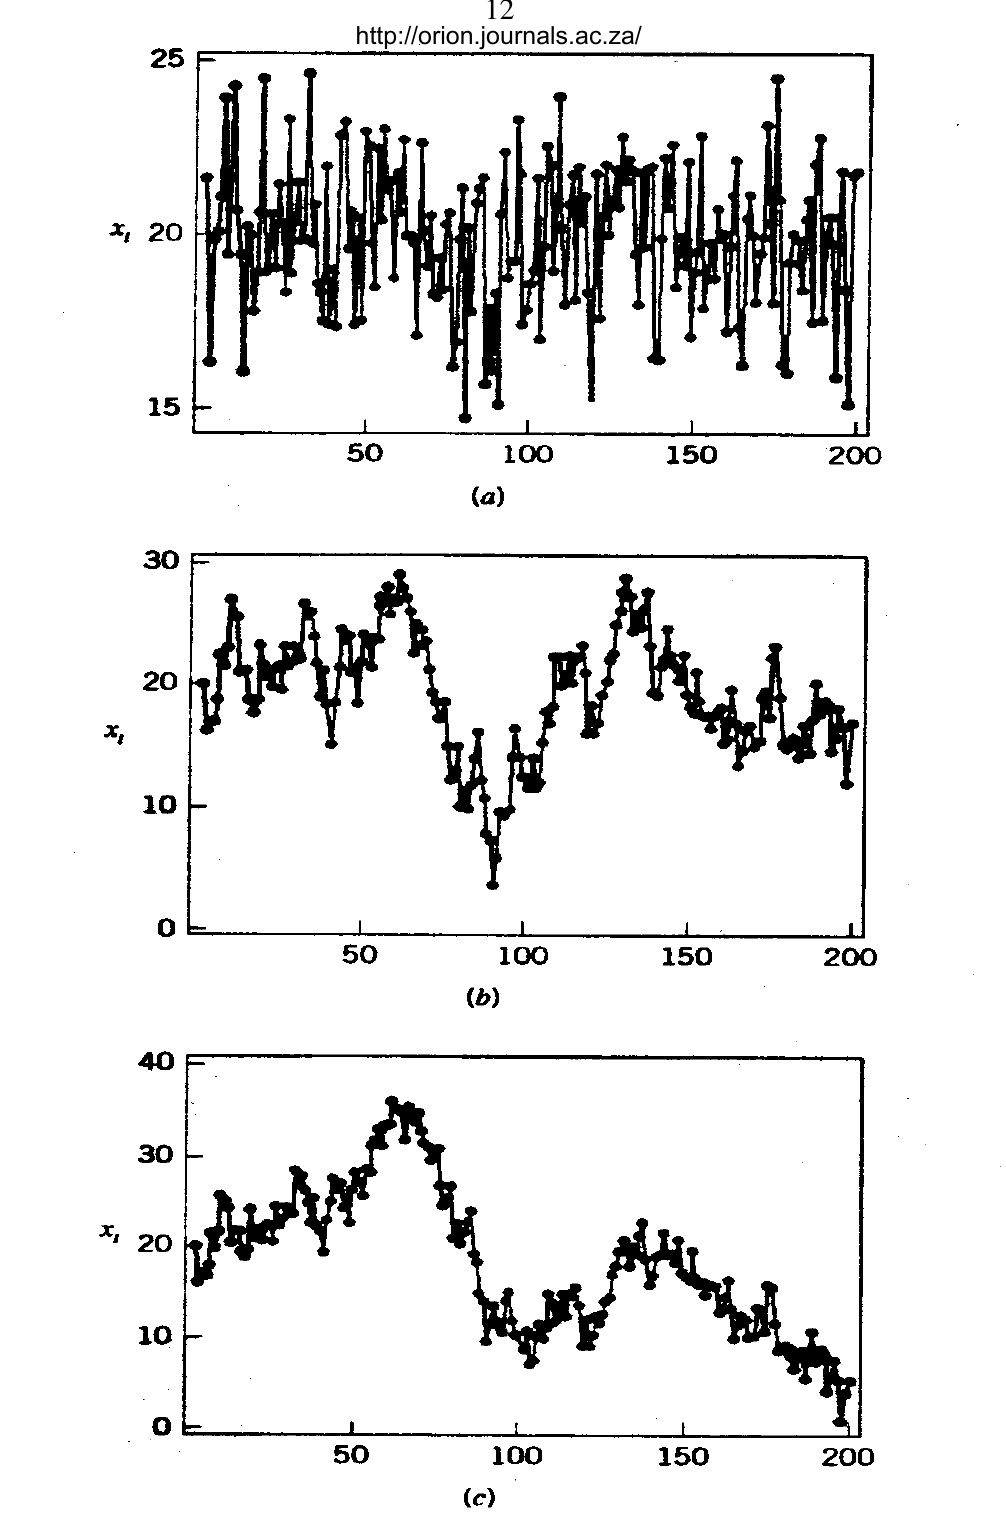
Figure 1. Data from three processes. (a) Stationary and uncorrelated. (b) Stationary and autocorrelated. (c)